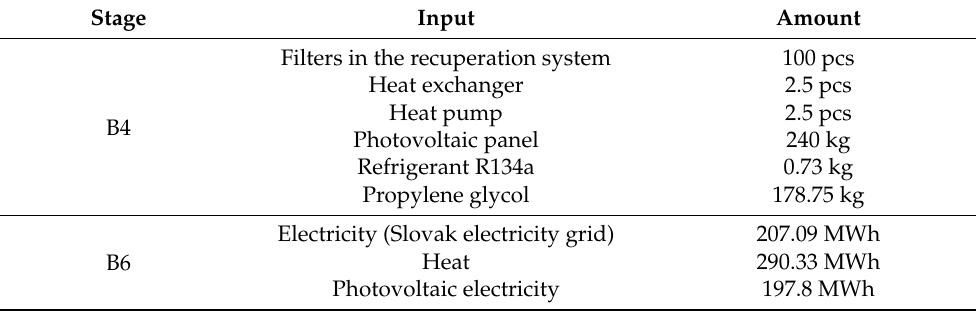
Table 2. Data used to model B4 and B6 life cycle stages regarding photovoltaic energy